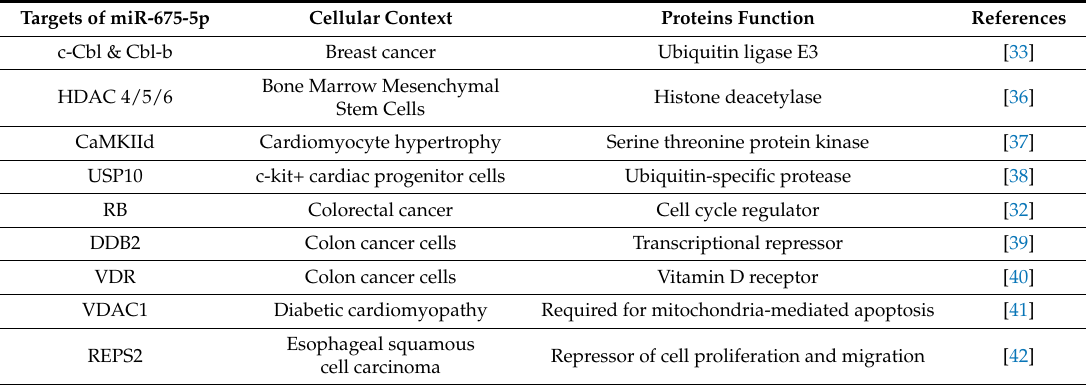
Table 1. Validated targets of miR-675-5p and